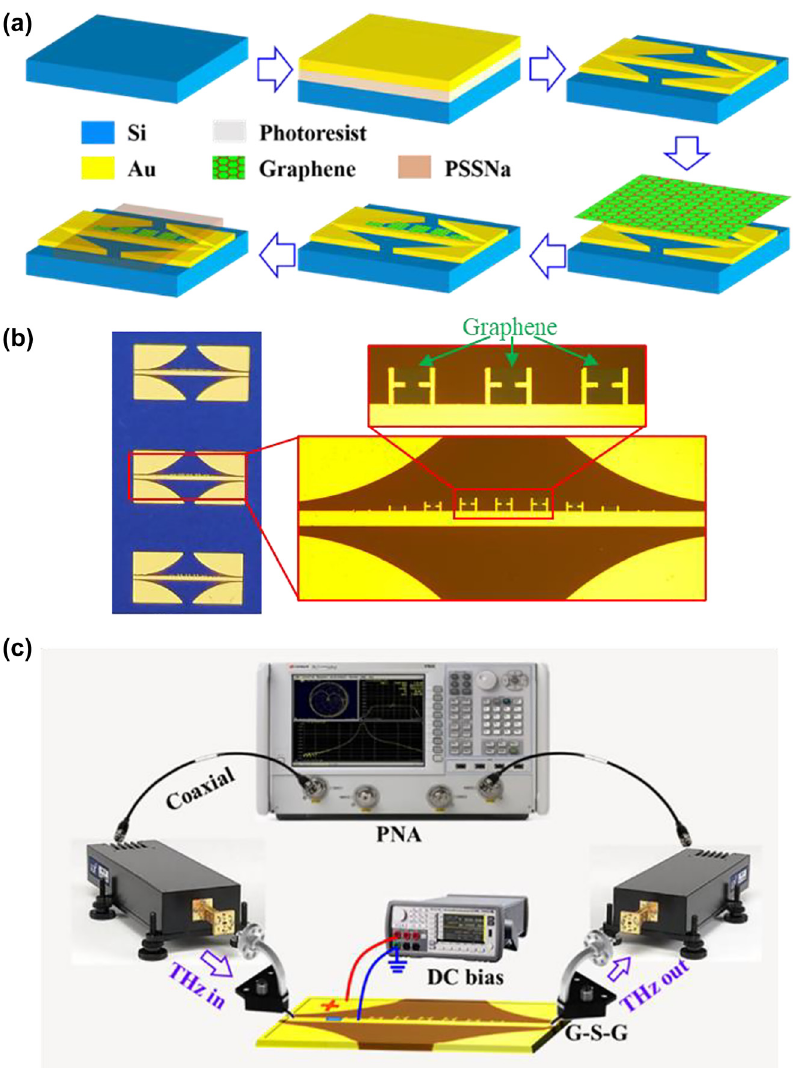
Figure4: Fabricatedmetal–graphenehybrid SPP structure. (a) Fabrication steps, (b) image of the fab- ricated device, and (c) measurement system set-up. increases from 5 to 8 dB at 140 GHz and from 8 to 15